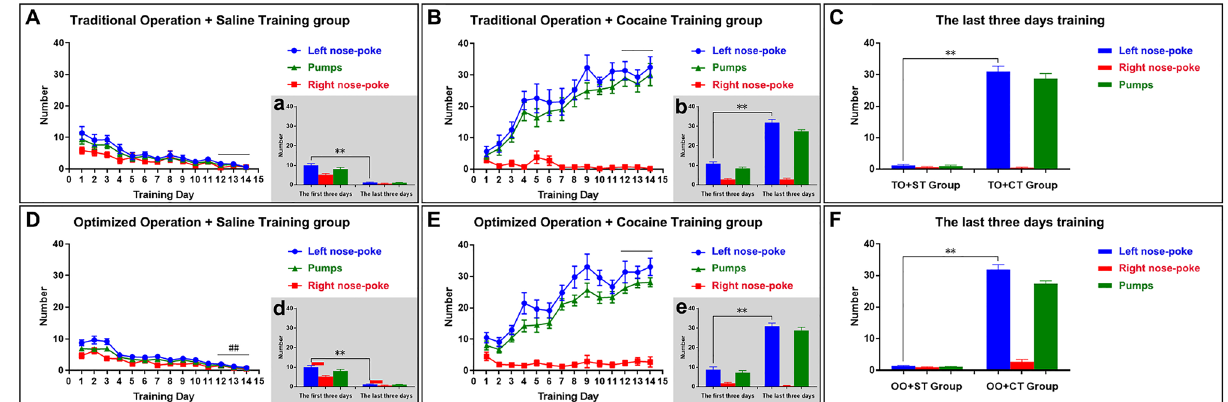
Figure 5. Effective establishment of cocaine self-administration model for rats. ( A , B , D , E ) The cocaine self-administration training everyday. ( A ) Traditional Operation + Saline Training group (n = 15): Compared to the first three days, the number of valid nose-poke for the last three days decreased [Day 1–3 : 9.9333 ± 1.002, Day 12–14 : 1.222 ± 0.2480, t TO+ST group = 8.243, P < 0.01 (a)] during saline SA training period and reached a relatively stable level during the last three days of training period (F TO+ST group = 2.587, P = 0.1180). ( B